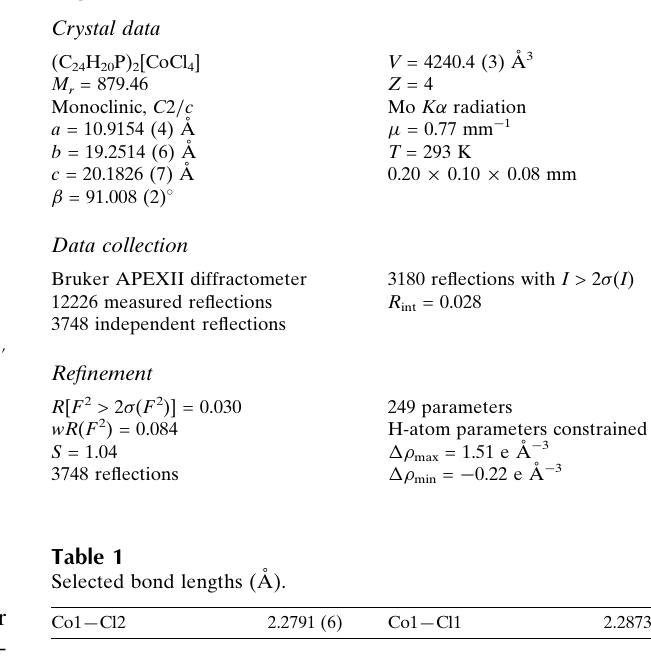
Selected bond lengths (A˚ ).